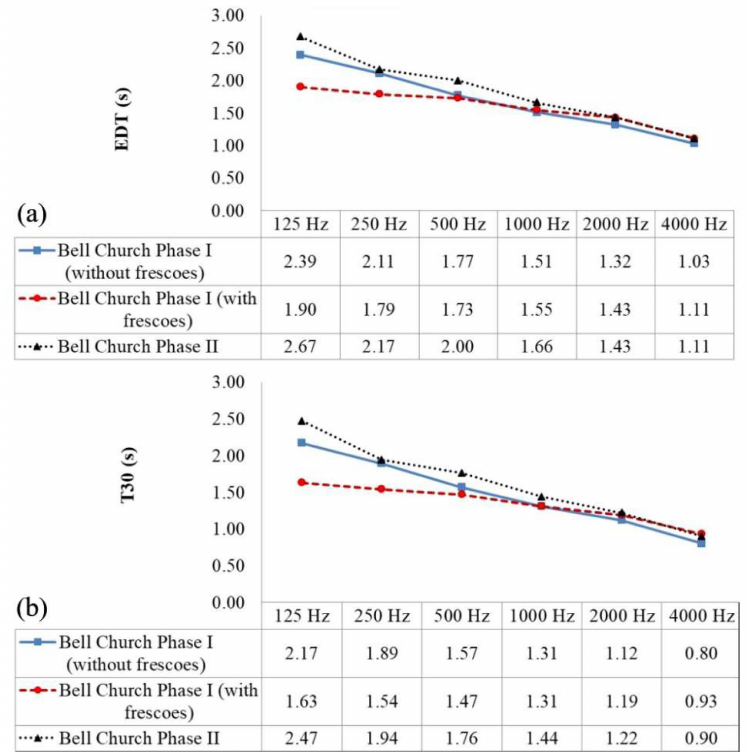
Figure 14. ( a ) EDT; ( b ) T30 over 1/1 octave bands for Bell Church acoustical models. The highest EDT of 2.42 s and a T30 of 1.60 s at the mid-range frequencies is observed in Phase II of Bell